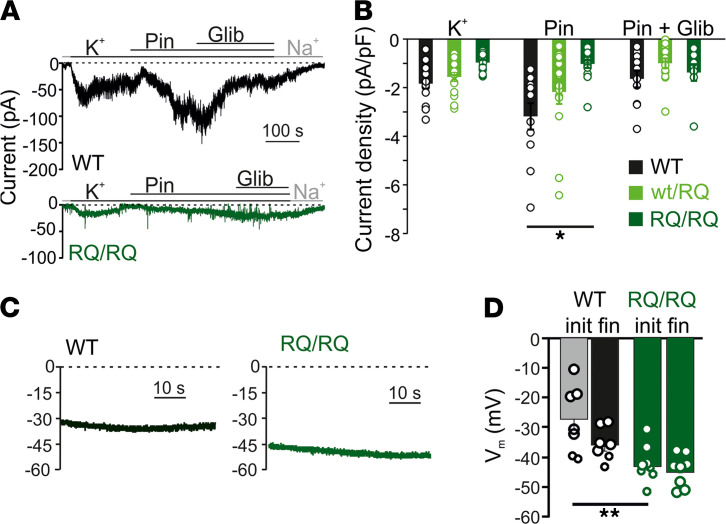
Loss of pinacidil-sensitive SUR2-dependent KATP channels in SUR2A[R1154Q] vascular smooth muscle.(A) Representative whole-cell voltage clamp recordings from acutely isolated aortic smooth muscle cells from WT and SUR2RQ/RQ mice. Cells were voltage clamped at –70 mV. Glib, glibenclamide. (B) Summary of whole-cell current densities from voltage clamp recordings as in A, showing significantly reduced pinacidil-activated KATP conductance in SUR2RQ/RQ cells. Statistical significance was determined by multi-way ANOVA, followed by 2-tailed t test pairwise comparison with Bonferroni’s correction for multiple comparisons (adjusted α = 0.008); *P < 0.008. (C) Representative whole cell current-clamp recordings from acutely isolated aortic smooth muscle cells from WT and homozygous SUR2RQ/RQ mice using an intracellular pipette solution absent of nucleotides. (D) Summary of initial (init) and final (fin) membrane potentials from experiments as in C. Statistical significance was determined by 1-way ANOVA followed by Tukey’s tests; ** P < 0.01.